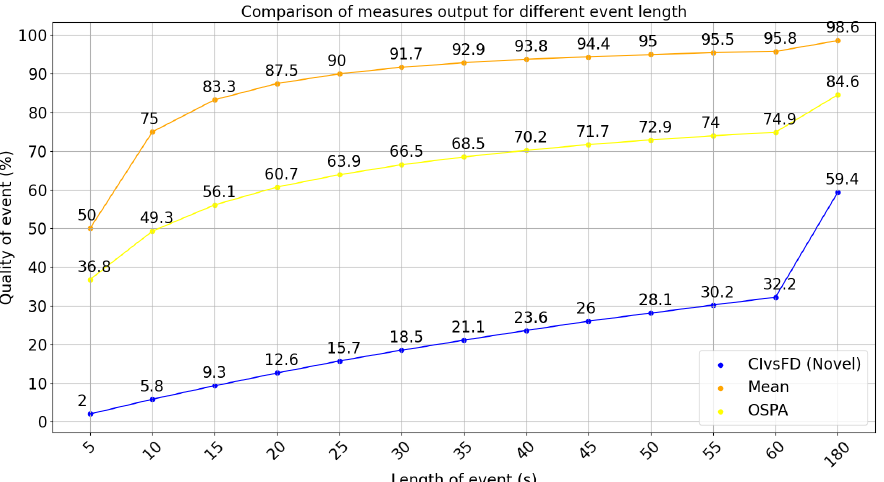
Figure 7. Comparison of tracking analysis measured with our approach and standard mean for situation with badly recognized initial maneuver (2.5